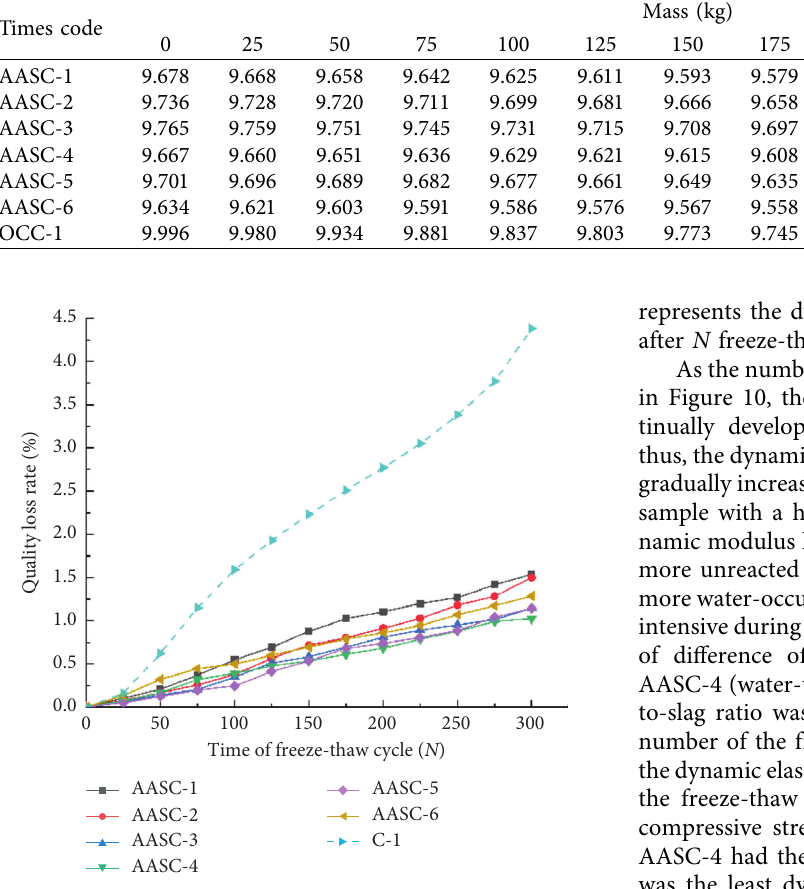
Figure 8: Relation between the mass loss rate and freeze-thaw